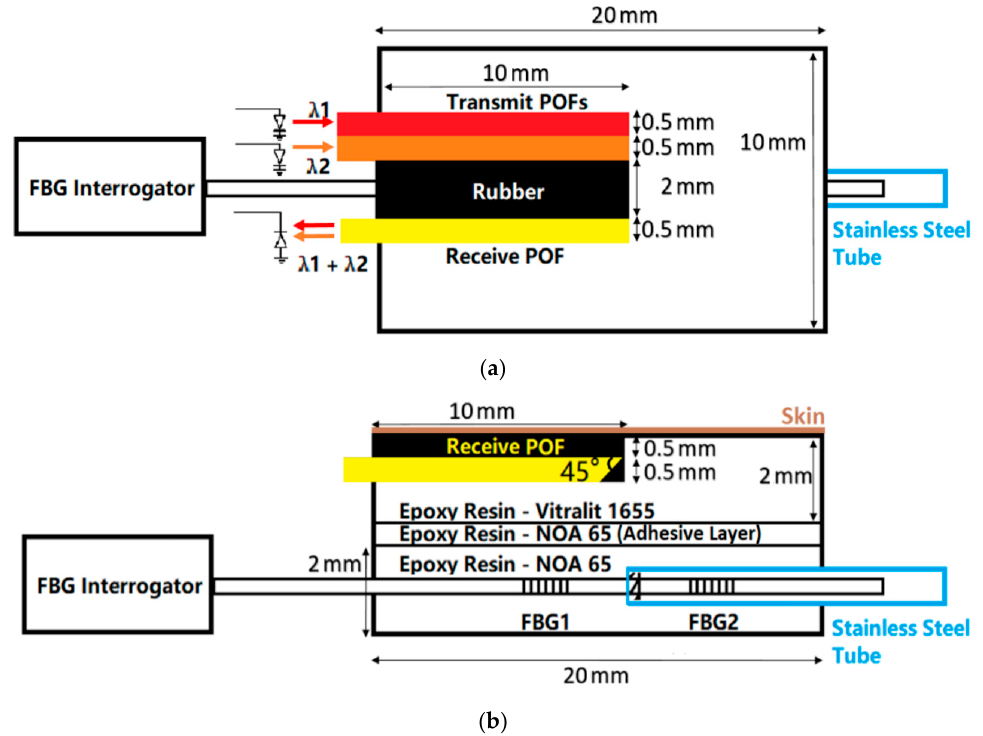
Figure 1. ( a ) Plan view of the probe. Red and orange frames represent transmit POFs connected to two LEDs (660 nm and 850 nm). The yellow frame represents the receiver POF connected to the photo-diode. ( b ) Side view of the probe. The probe consists of two epoxy rectangular patches which are connected using epoxy resin. The top patch is the pulse oximeter whilst the bottom is the FBG pressure sensor. Two FBGs are fabricated in the core of the silica fibre which are connected to the FBG interrogator (see Section 2.2). The brown line represents the skin surface where the POFs are located. The bottom substance of the pulse oximeter patch is made of epoxy resin (Vitralit 1655, Panacol-Elosol GmbH, Steinbach, Germany) which is a biocompatible material. Exposing to UV light with a maximum absorption within the wavelength range of 350–380 nm for 15 min, the epoxy resin is cured in a mould into a 20 × 10 × 2 mm cube. There is one 3.5 × 10 × 1 mm slot on the top surface of the epoxy cube generated by polishing. Three POFs with 45° cleaved and polished ends are set into this slot and then fixed by filling and curing the epoxy resin. Black rubber (2 mm thick) on the surface of the epoxy patch between transmit and receive POFs is present to prevent light passing directly from the source to the detector as this would affect Idc and hence the S p O 2 value (Equation (2)). For contact pressure sensing, two FBGs, separated by 6 mm are written into a 125 µm diameter photosensitive silica optical fibre (PS1250, Fibercore Ltd., Southampton, UK) using a UV inscription method previously described [21]. Encasing an FBG in epoxy transduces a transverse load into an axial strain. However, temperature changes will cause shifts to the Bragg wavelength and therefore a reference FBG is required to compensate. The reference FBG is shielded in a stainless-steel tube